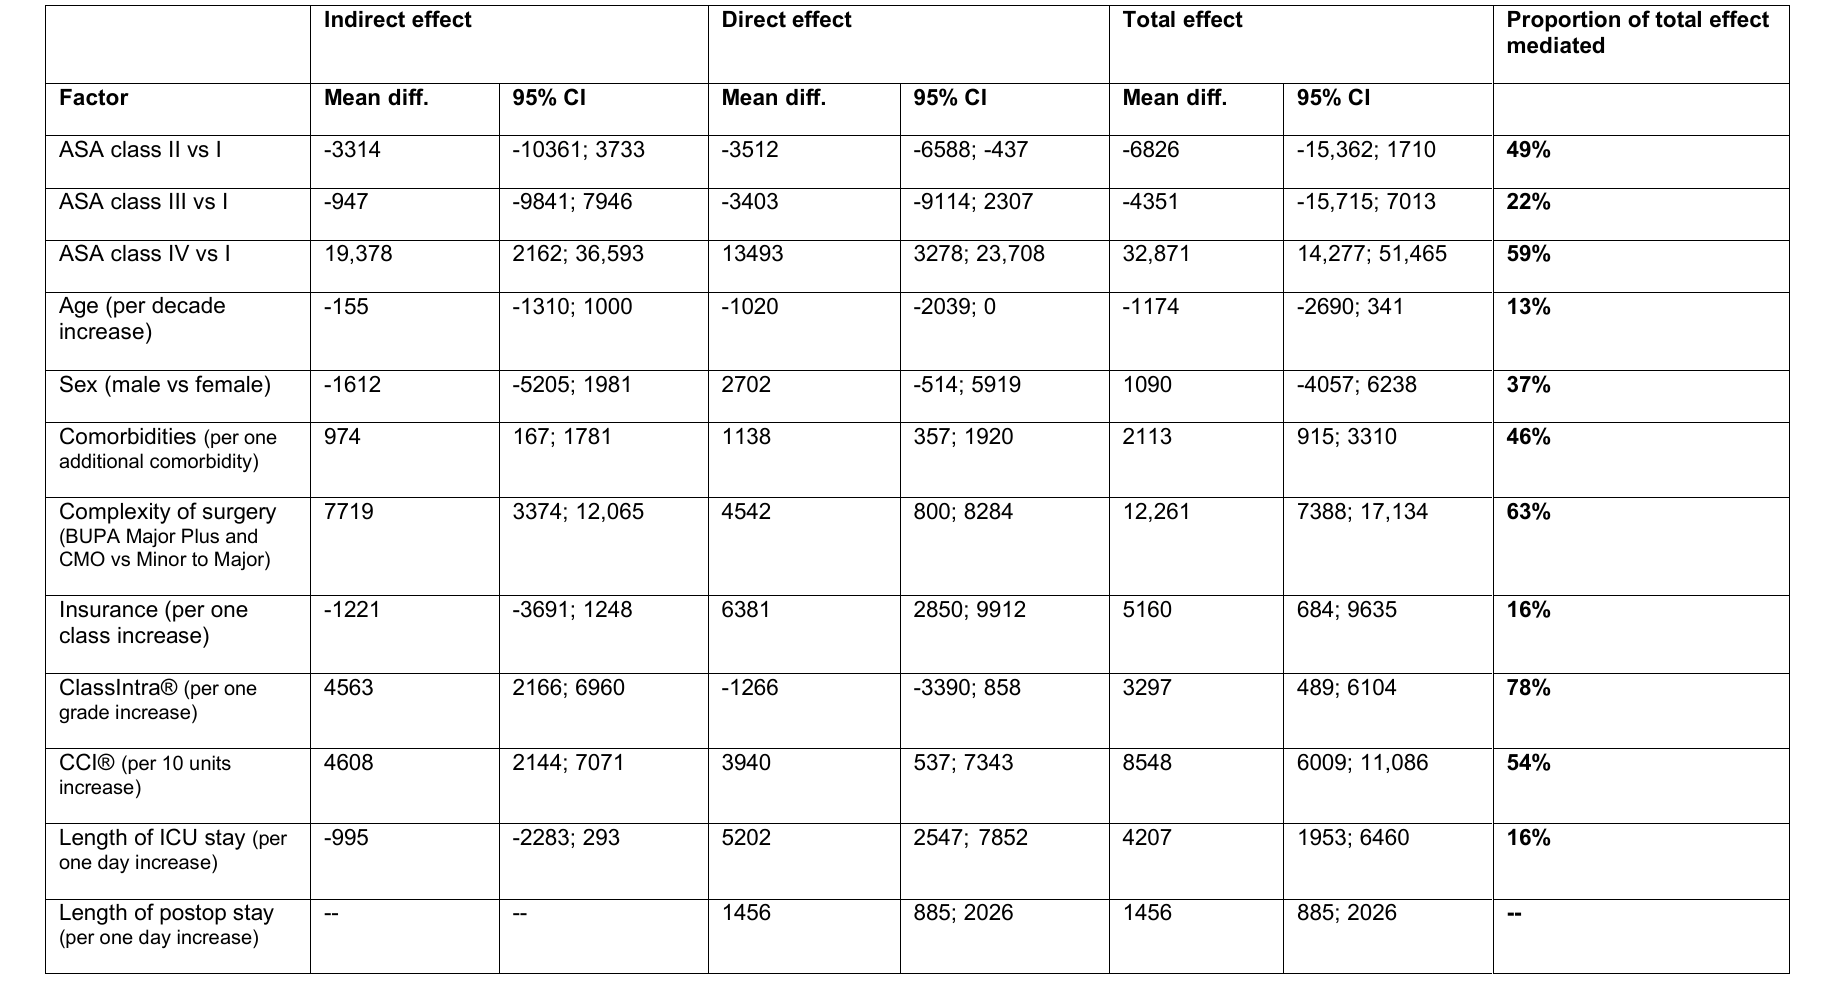
Table 4: Cost model including all patients (in Euros) Indirect, direct and total effects on costs. Coefficients are mean differences in cost; all patients were included(n=320), and age and sex were considered as additional covariates. R-squared